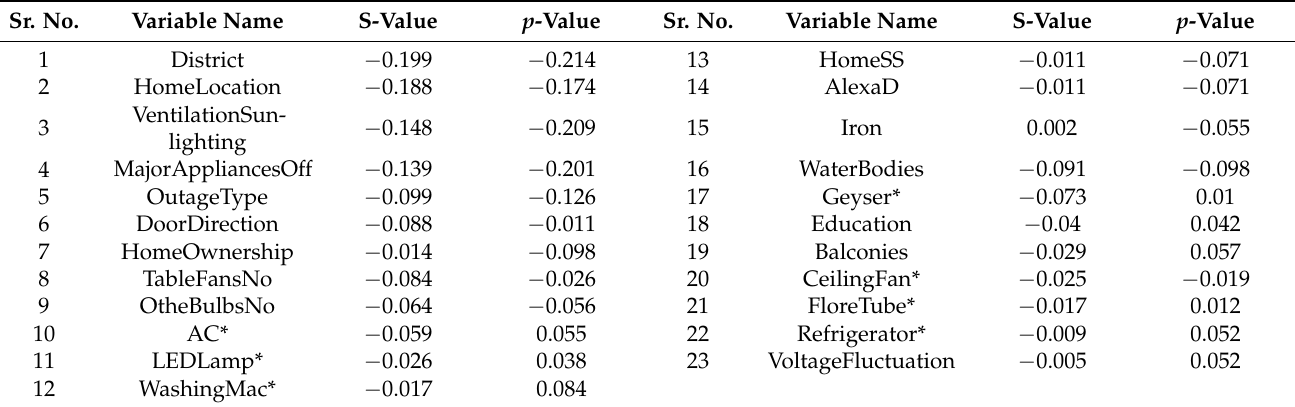
Table 4. The poorly associated variables with the target